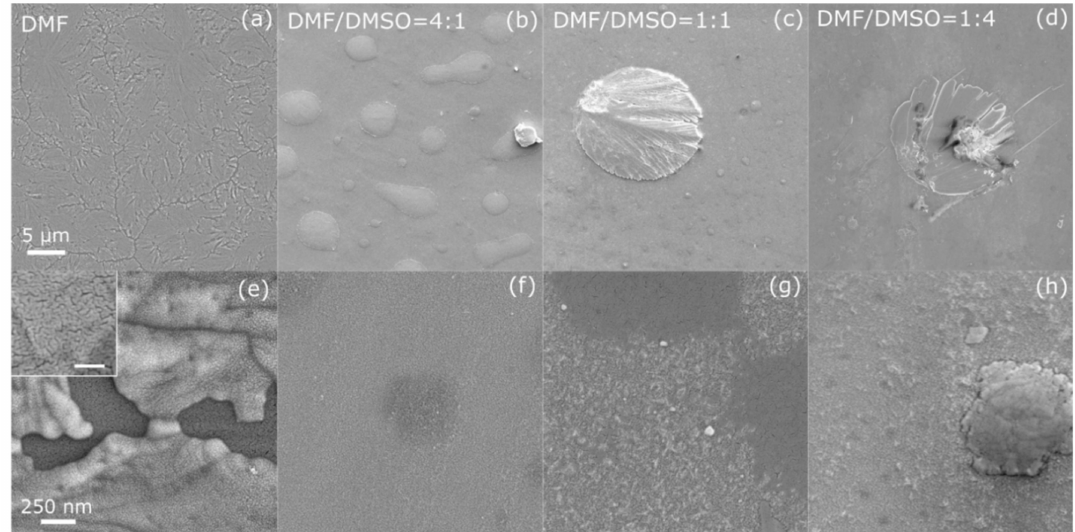
Figure 1. Scanning electron micrographs taken at low ( a – d ) and high ( e – h ) magnification on (PRSH)PbBr 3 films prepared in DMF ( a , e ) and in mixed DMF/DMSO solvents with a volume ratio of 4:1 ( b , f ), 1:1 ( c , g ) and 1:4 ( d , h ). The scale bars in the left panels apply to all micrographs in the same line. The inset in ( e ) shows a high magnification micrograph of the uppermost portion of the film in ( a ), with a 100 nm scale